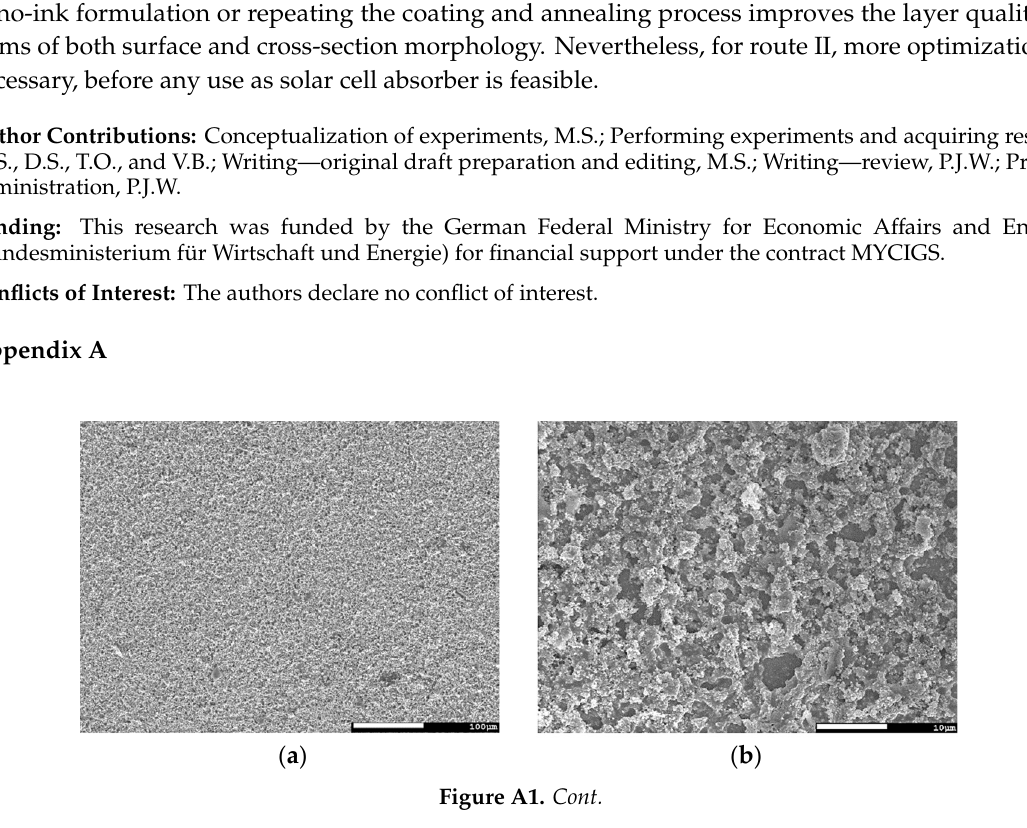
( d ) Figure A1. Scanning electron microscopy (SEM) top view image series of a CuInSe 2 (CISe)‐film from Cu‐In + Se precursor after face‐to‐face annealing at 550 °C for 5 min with 46.1 kN/m² at different magnifications, ( a ) 200×; ( b ) 2,000×; ( c ) 10,000×; ( d ) 30,000×. ( a )